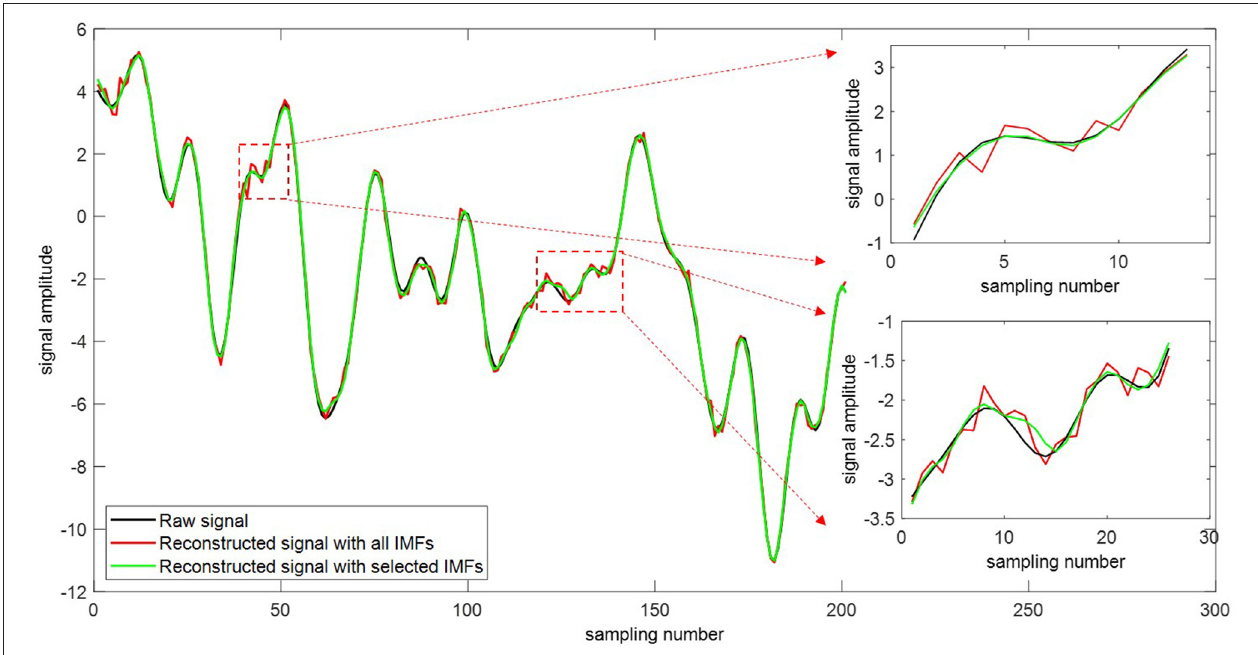
FIGURE 9 | Comparison of time-domain signals with reconstructed signals.